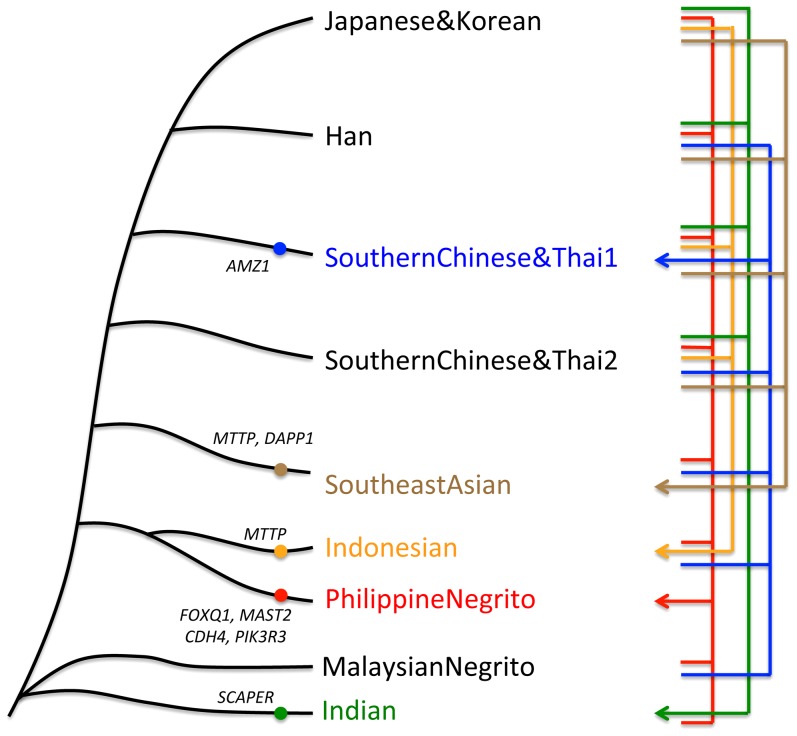
Outstanding candidate genes underlying local adaptation show consistency in related population groups.The genetic distance tree was constructed based on the global FST of those 9 groups. The genes shown in circles on the tree were selection signals specific to the corresponding group (as the arrows point). They presented great allele frequency differentiations in the comparisons of local group and other groups joint by the line of the same color (on the right) as the arrow.